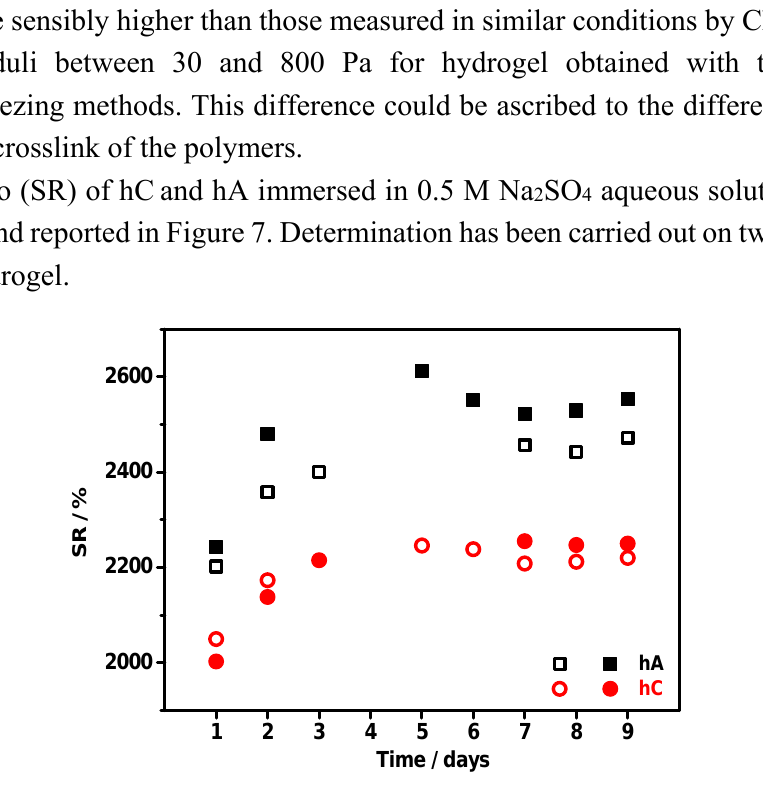
Figure 7. Time dependence of the swelling ratio of hC and hA immersed in 0.5 M Na 2 SO 4 aqueous solution at RT (for each hydrogel determination has been carried out on two different